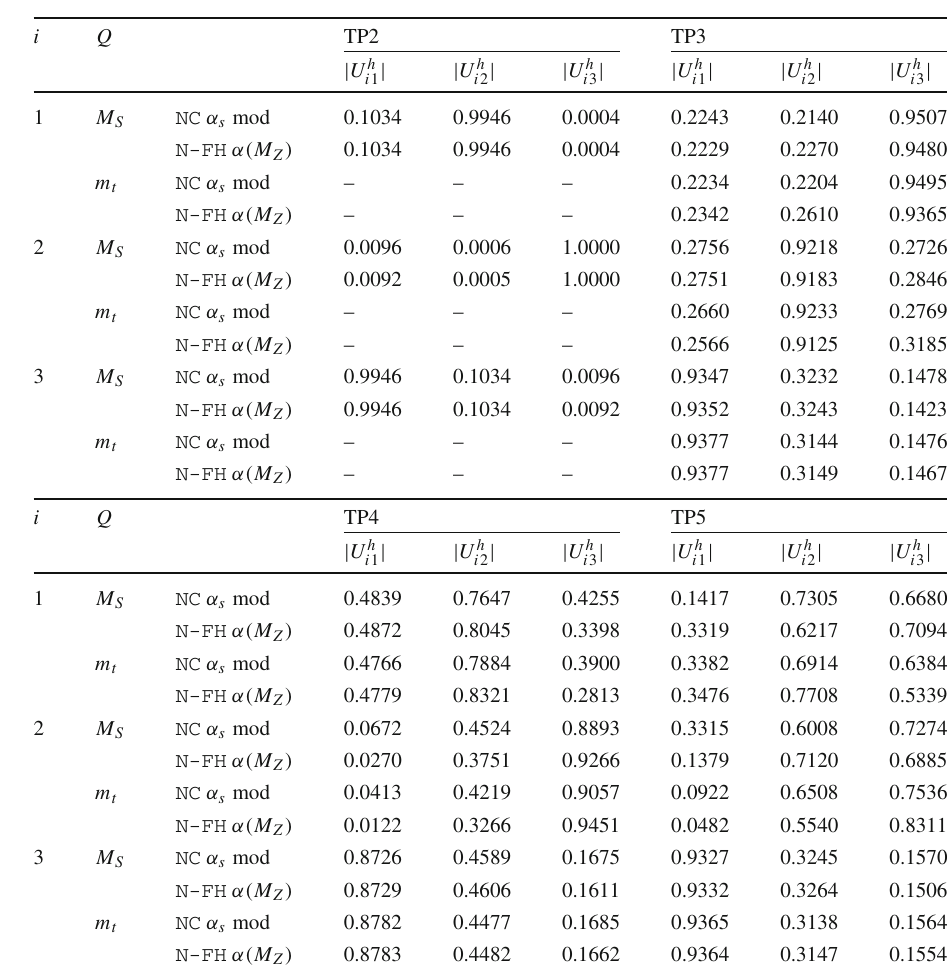
mixing-matrix elements for TP2–TP5 when using the indicated versions of NMSSMCALC and NMSSM-FeynHiggs as specified in the text; see Sect.